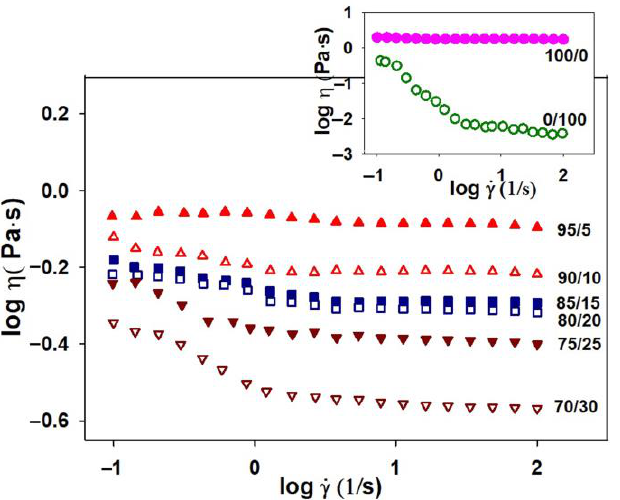
Figure 1. Rheological profile illustrated by double-logarithmic plots of dynamic viscosity ( η ) vs. shear rate ( γ̇ ) for pure HPMC, PVP (small plot) and HPMC/PVP studied systems at various mixing ratios and 25 °C.